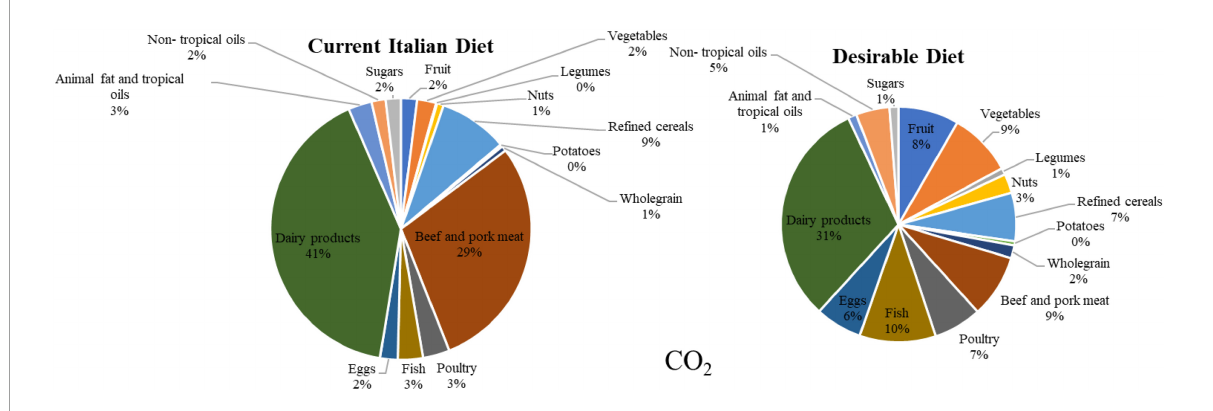
FIGURE2 CO 2 emissions associated with the weekly consumption of foods in the desirable and the current Italian diet (Source: Authors).